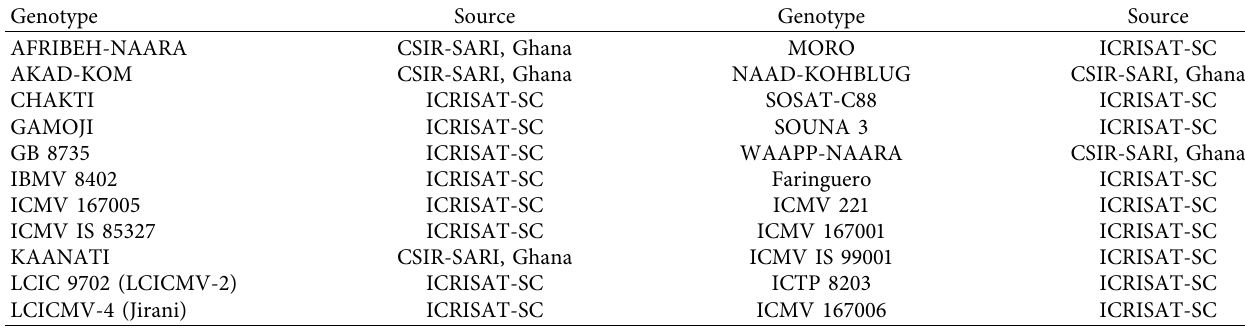
Table 1: List of hybrids and OPVs used for AMMI stability